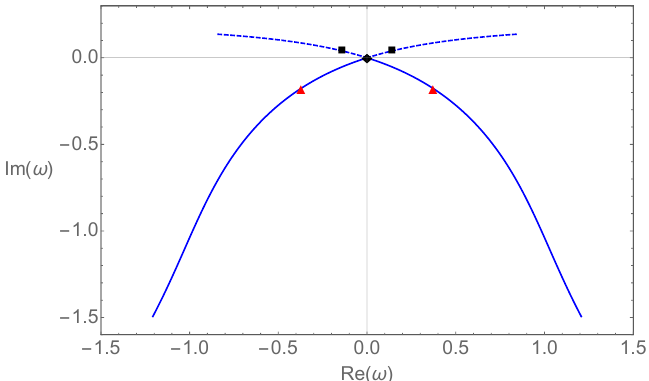
Figure 11 . The behavior of the two lowest lying scalar quasi normal modes in the normal solution moving across the 2nd order phase transition. The rhombus indicates the position of critical